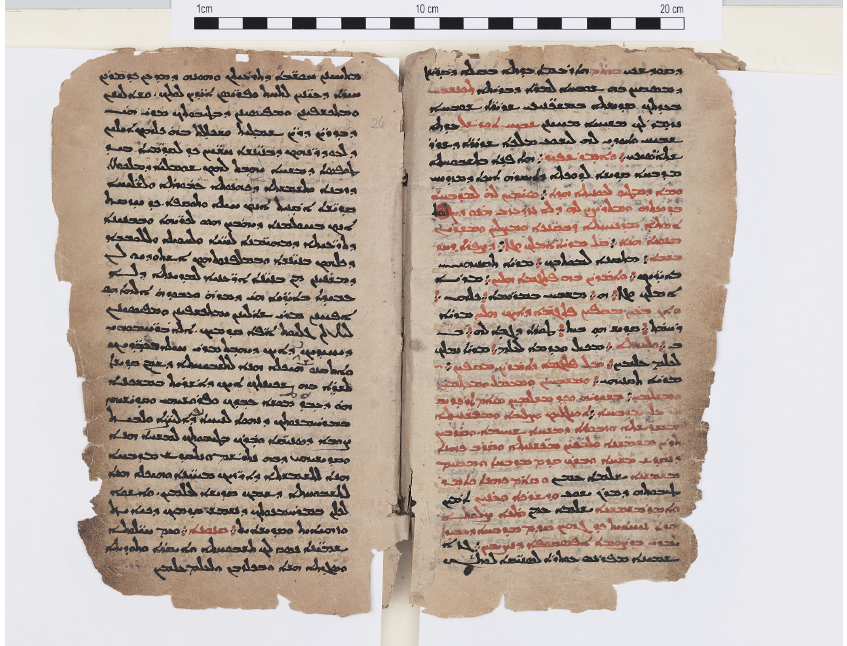
Figure 7 MIK III 45 fol. 25 verso ll. 27-30. Rubric naming Barsauma, bishop of